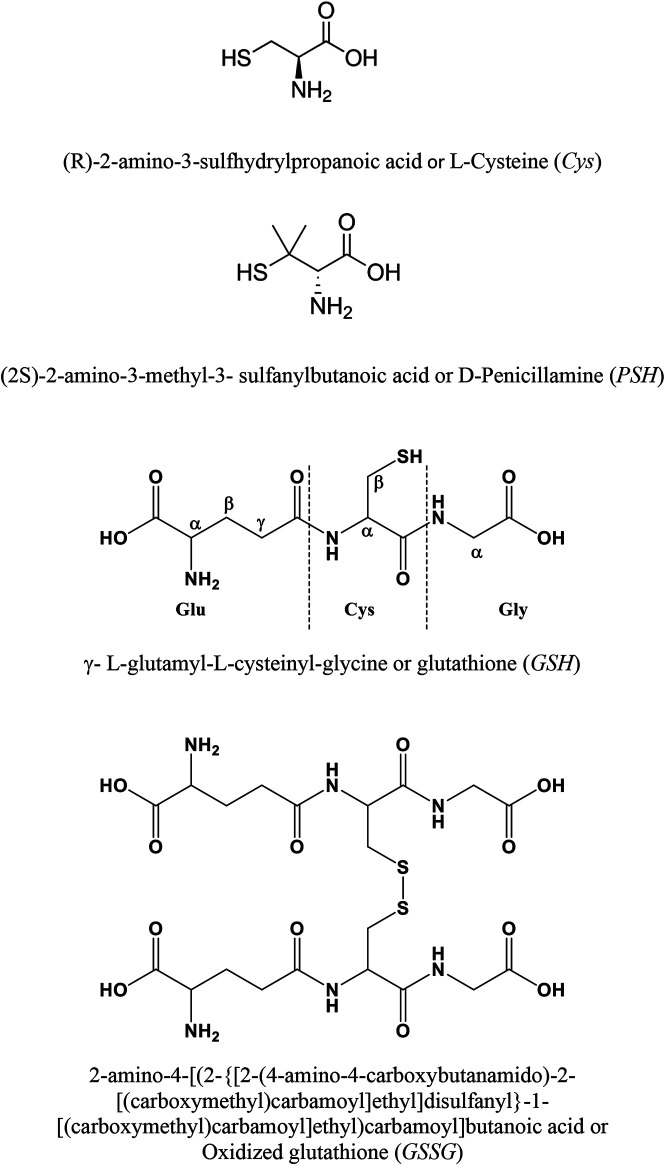
Ligands under study.